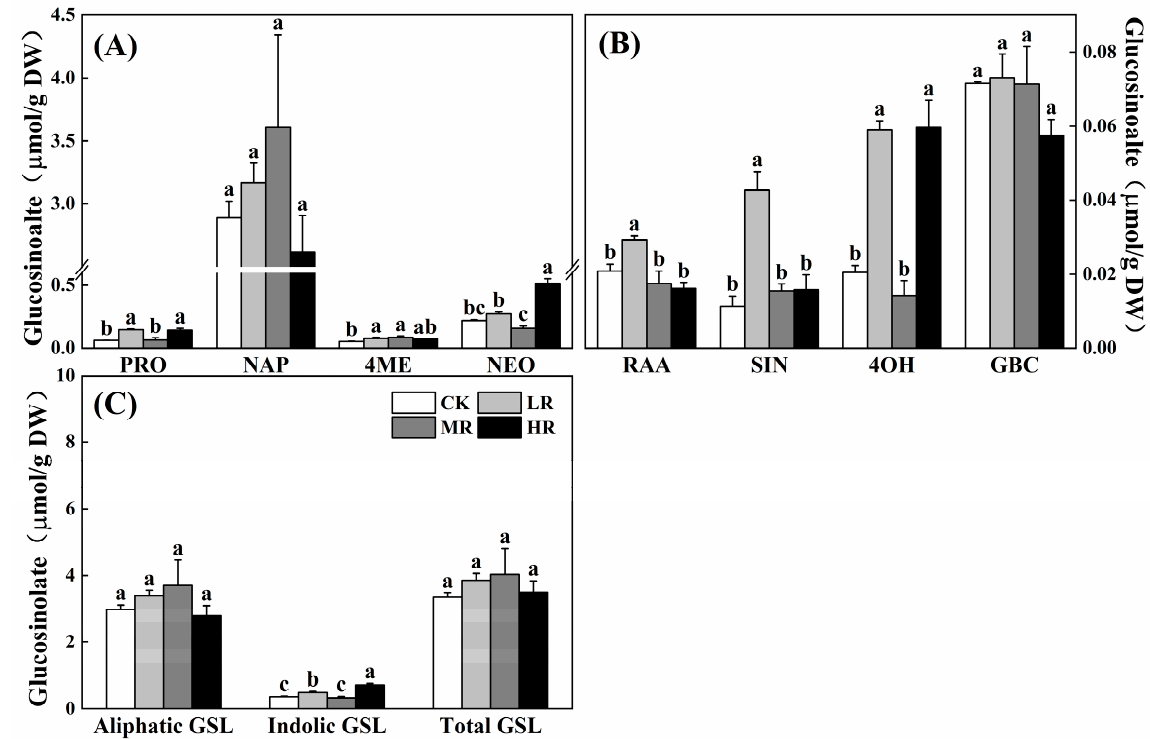
Figure 6. CK: only white light, LR: red:white = 1:2, MR= red:white = 1:1, LR = red:white = 2:1. The contents of eight different GSLs ( A , B ) and different sorts of GSL content ( C ) of pak choi grown under the different ratios of red and white light treatments. The specific aliphatic GSL species are as follows: progoitrin (PRO); gluconapin (NAP); glucoraphanin (RAA); sinigrin (SIN), and specific indolic GSL species are as follows: 4 ‐ methoxyglucobrassicin (4ME); neoglucobrassicin (NEO); 4 ‐ hydroxygiucobrassicin (4OH); glucobrassicin (GBC). All values are expressed as mean ± standard error ( n = 3). The letters marked in all figures indicate the significance of the difference ( p ≤ 0.05, Duncan’s test).